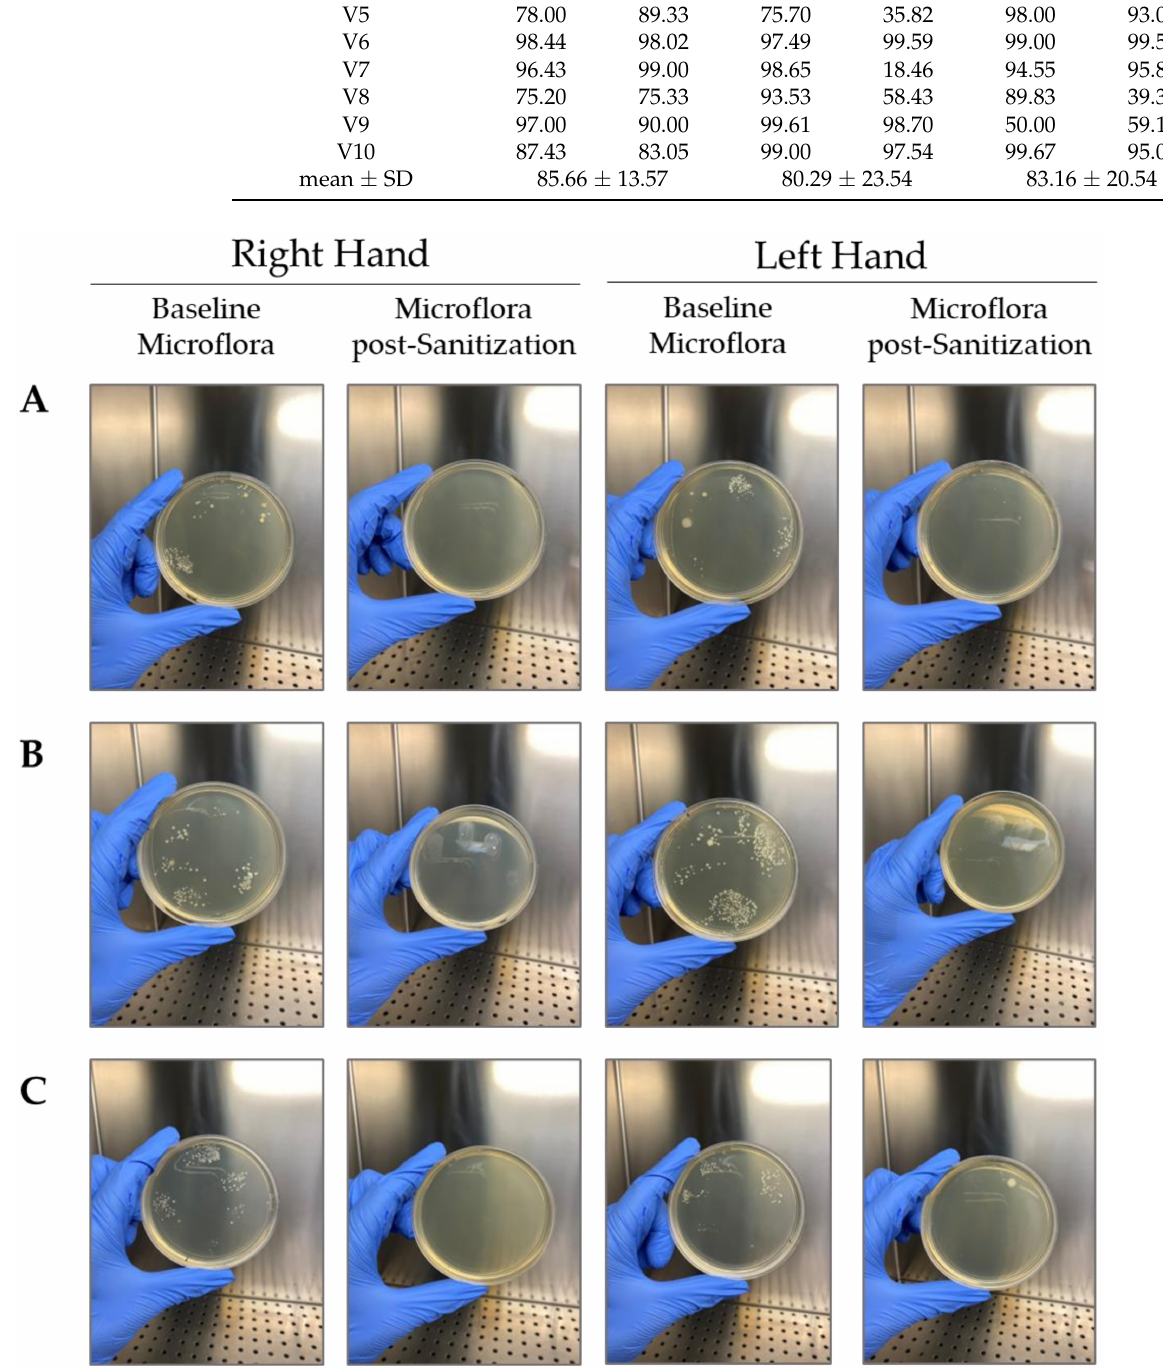
Figure 5. Graphical representation of TSA plates after finger impression in unwashed hands condition (Baseline Microflora) and after clean with the three hand sanitizers object of the study (Microflora post-sanitization): ( A ) formulation with hydroxyethylcellulose (HEC); ( B ) formulation with carbopol (CBP); ( C ) formulation 1—WHO. The picture shows the results obtained for each hand sanitizer on the right and left hand of a subject selected